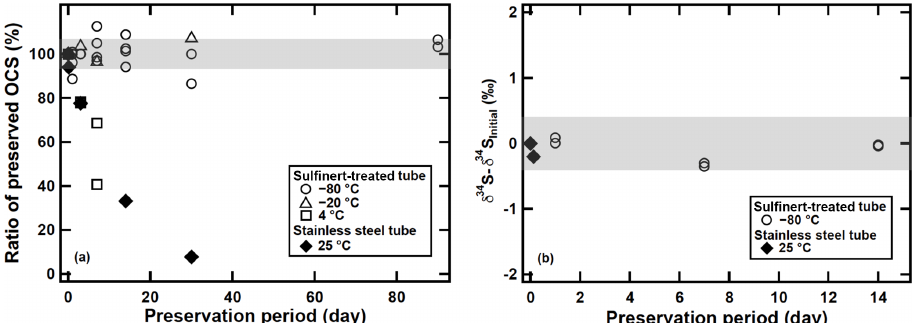
Figure 8. (a) Changes in OCS concentrations preserved in the OCS storage test in adsorption tubes at different temperatures and tubes. (b) Changes in δ 34 S(OCS) preserved in the OCS storage test. The shaded bar shows ± 6% for OCS concentration and ± 0.4‰ for the δ 34 S(OCS) value based on the precisions of syringe injection and the flow rate of the diaphragm pump in the sampling